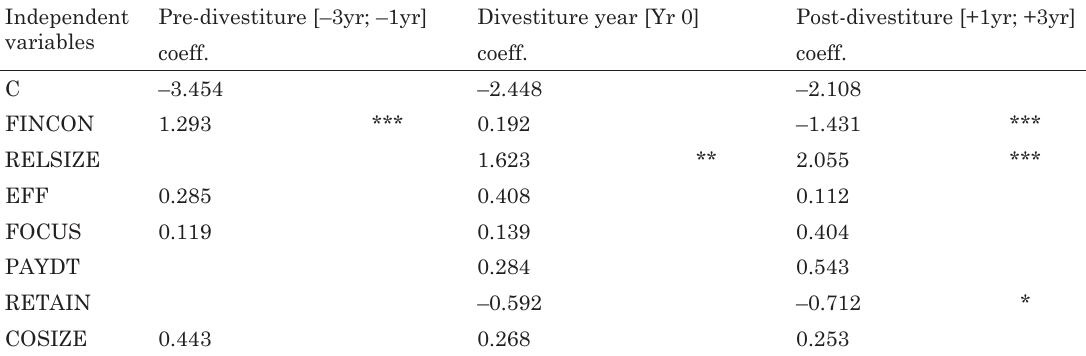
Table 4. Summary of logistic regressions